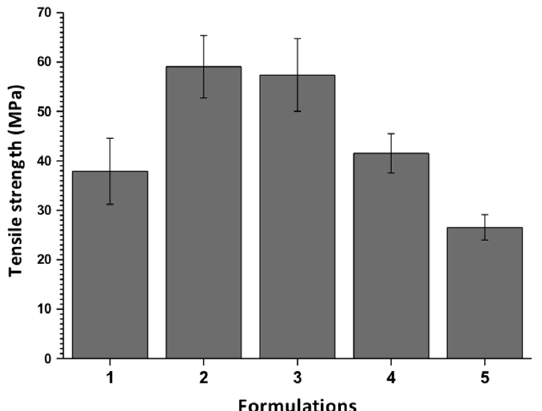
Figure 6. The tensile strength of CS/PVA/GO films. Data are shown as mean ± standard deviation of the mean ( n = 5).